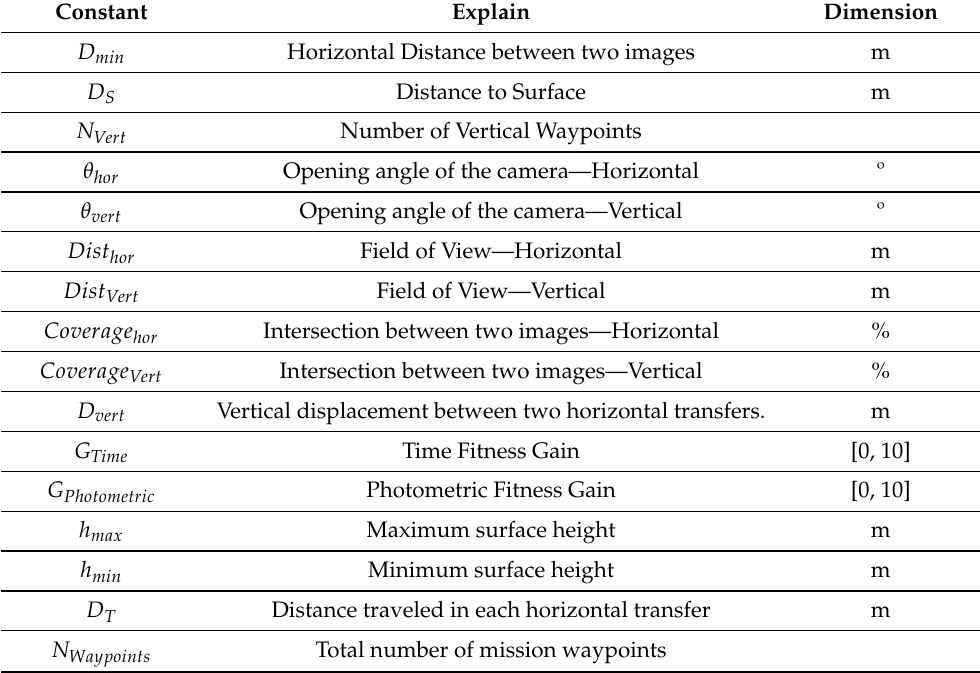
Table 1. Summary of